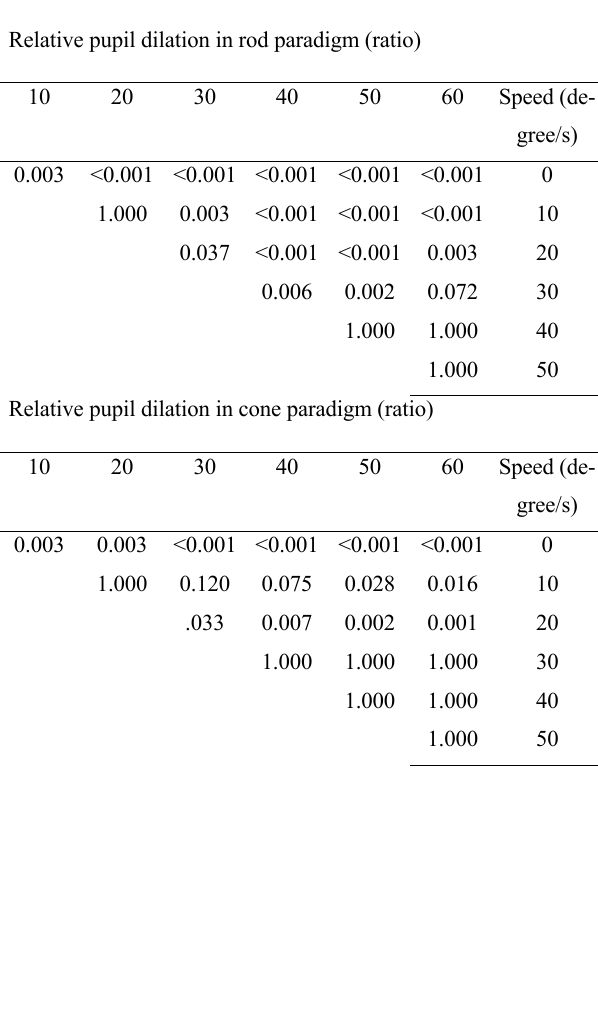
Table 4. P-value of comparison between speeds for relative and absolute pupil dilation in cone and rod